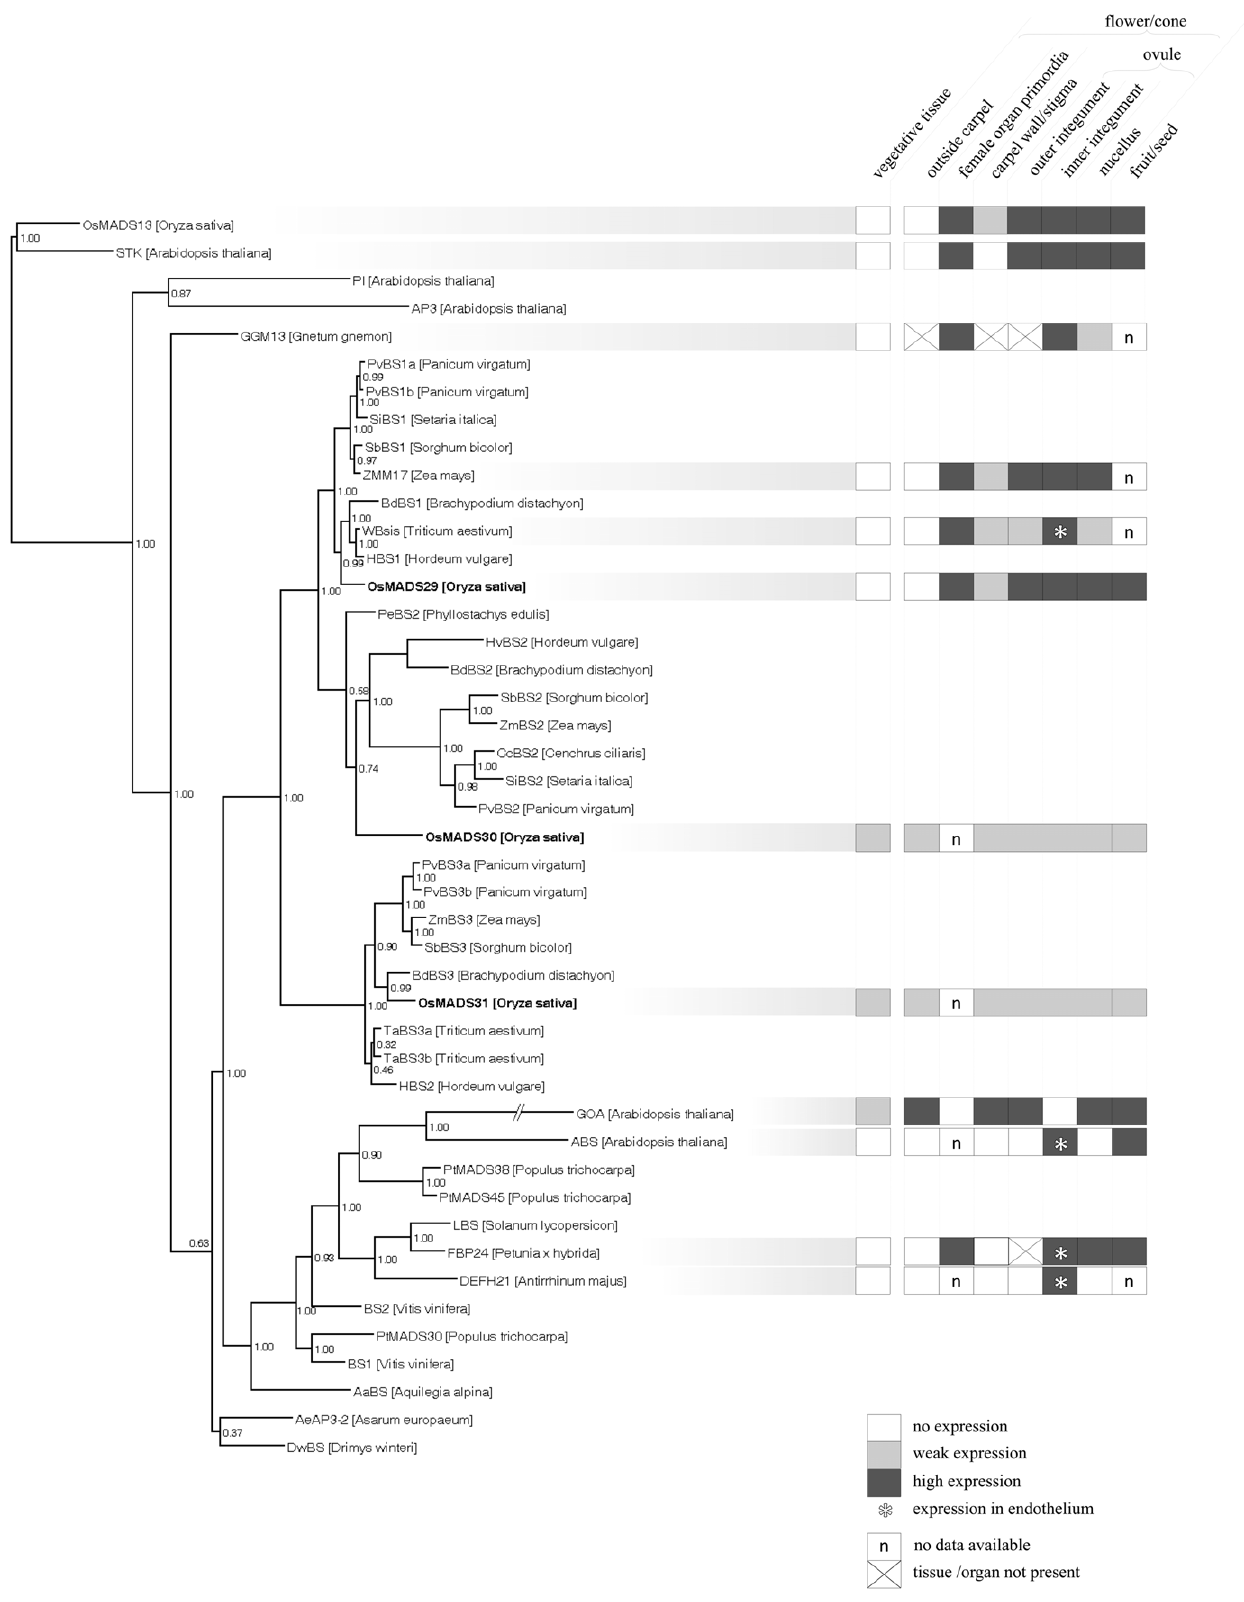
Figure 1. Phylogeny and expression patterns of B sister genes. Bayesian phylogeny of class D, class B and B sister genes in seed plants. Posterior probabilities are indicated on the nodes. The expression patterns of B sister and class D genes are depicted as far as they are known. Colors indicate expression intensity: white, no expression; light grey, weak expression; dark grey, strong expression; asterisk, expression was detected particularly in endothelial cells of inner integument; n, no expression data available; cross, tissue or organ is not present in respective species. doi:10.1371/journal.pone.0051435.g001 PLOS ONE | www.plosone.org